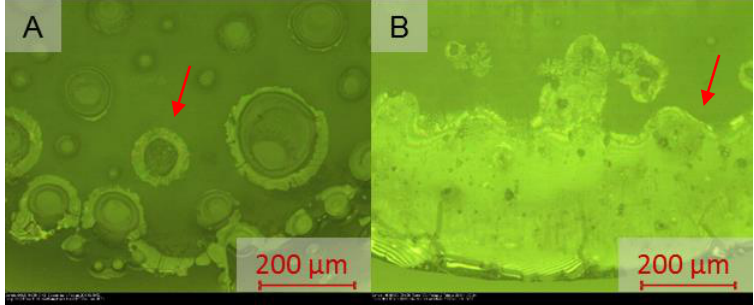
Figure 7. Different drying mechanisms of foams with ( A ) 20% and ( B ) 40% maltodextrin (MD) content, respectively, in the freeze-drying microscope during the first drying stage.